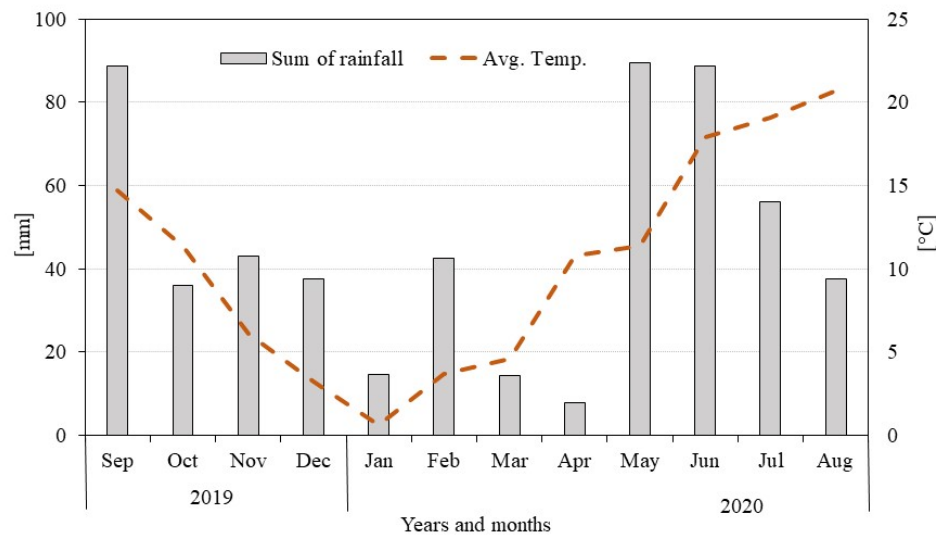
Figure 2. Meteorological conditions during vegetation of winter wheat.